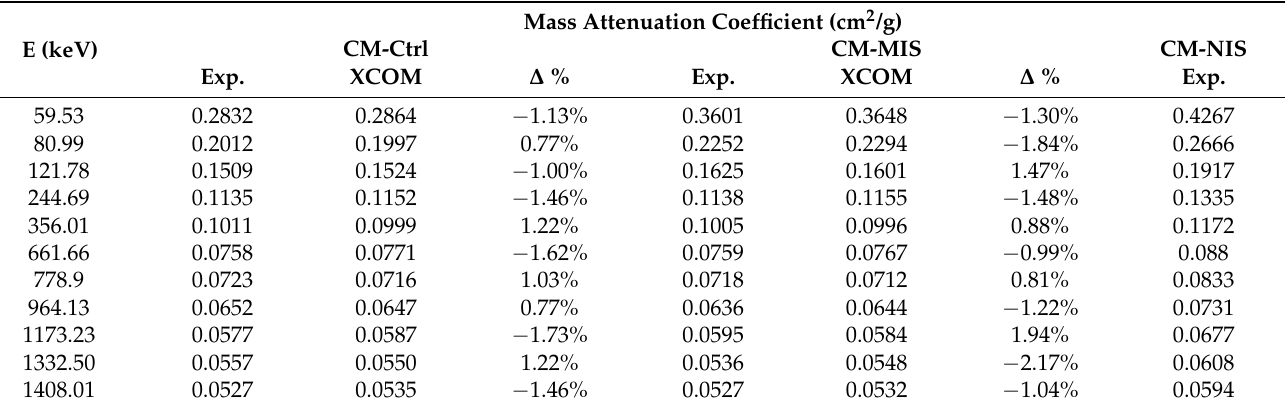
Table 6. The experimental and theoretical values of MACs and their relative deviations for CM-Ctrl, CM-MIS, and CM-NIS mortar